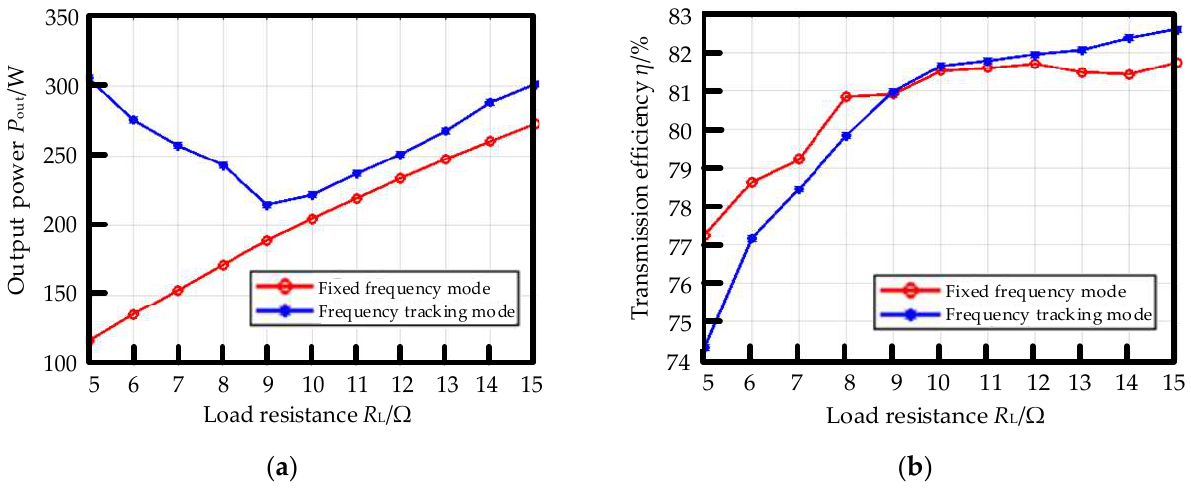
Figure 16. Different load and transmission characteristics diagram: ( a ) output power versus load resistance diagram; ( b ) transmission efficiency versus load resistance diagram.